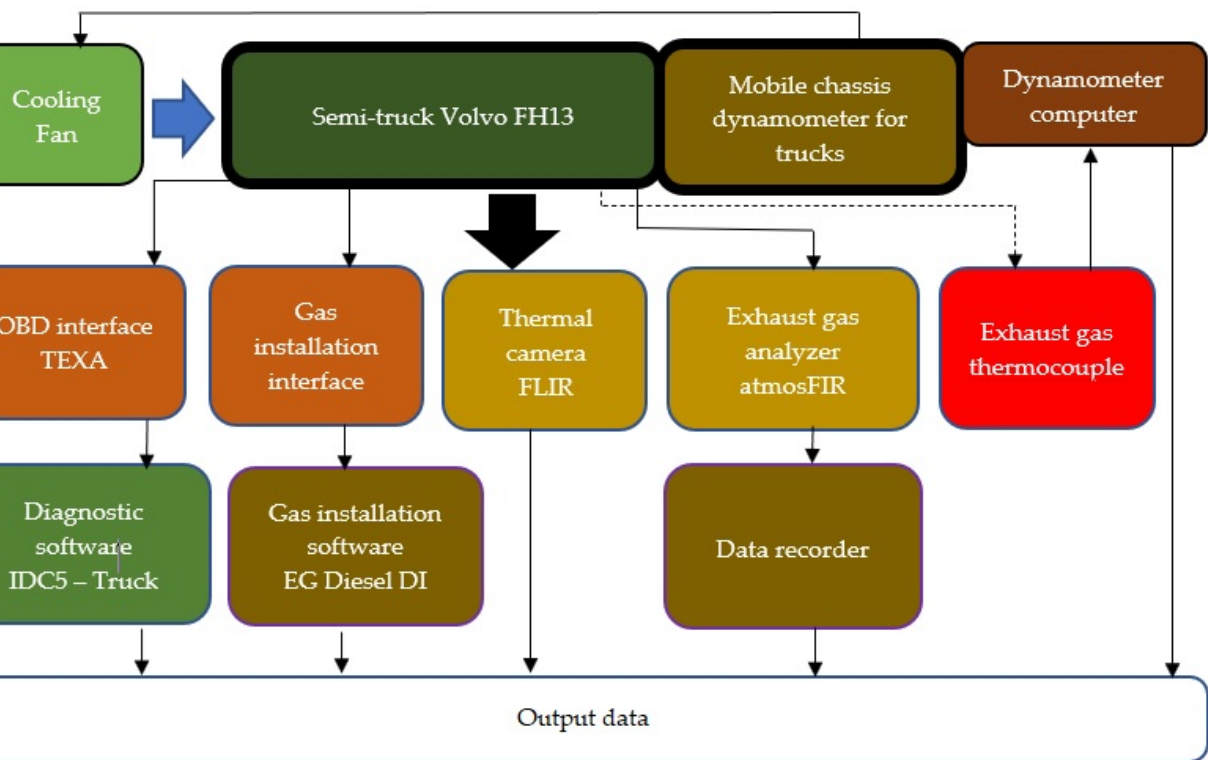
Figure 3. Block diagram of the test stand (authors’ source).